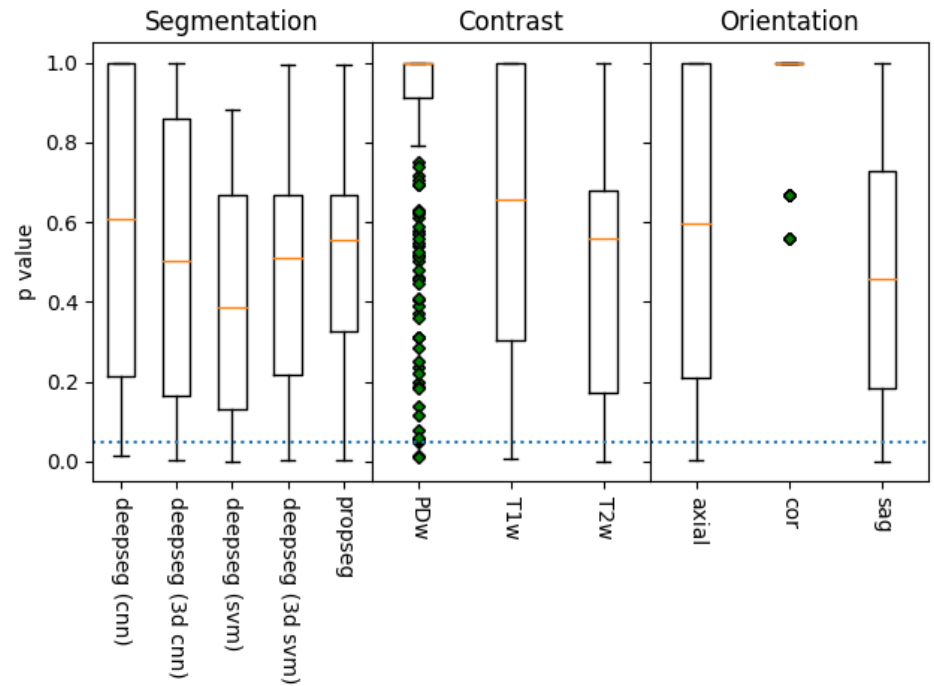
Figure 7. A box plot of the distribution p -values of metric to mJOA score correlations, grouped by acquisition contrast, orientation, and segmentation algorithm, as evaluated via SciKit-Learn’s ‘f_regression’ algorithm (lower is better). The dotted blue line represents the threshold of sig- nificance for this study ( p ≤ 0.05), with whiskers representing the maximum/minimum value of the set, or 1.5 times the inter-quartile range, whichever is shorter. Data points outside this range are denoted with green diamonds. Of the methods, it appears that segmentation using deepseg with a svm kernel provided the best results, as did those processed with a T2w contrast along the sagittal plane. However, all but coronal alignment appears capable of statistically significant metric extraction in at least some manner, though the PDw contrast is quite likely a fluke as well (due to its low sample